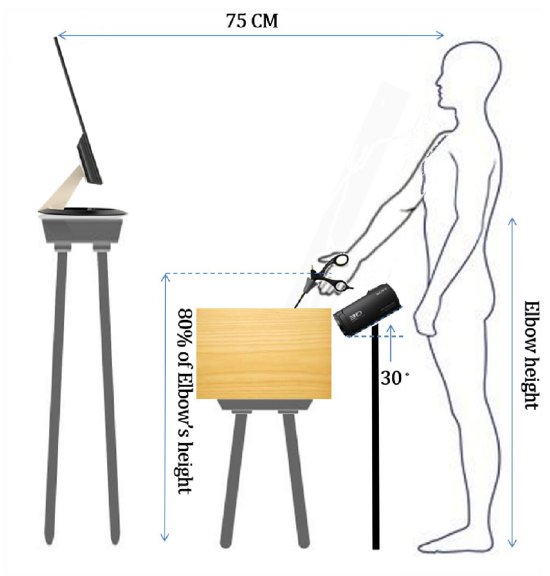
Figure 1. Experimental